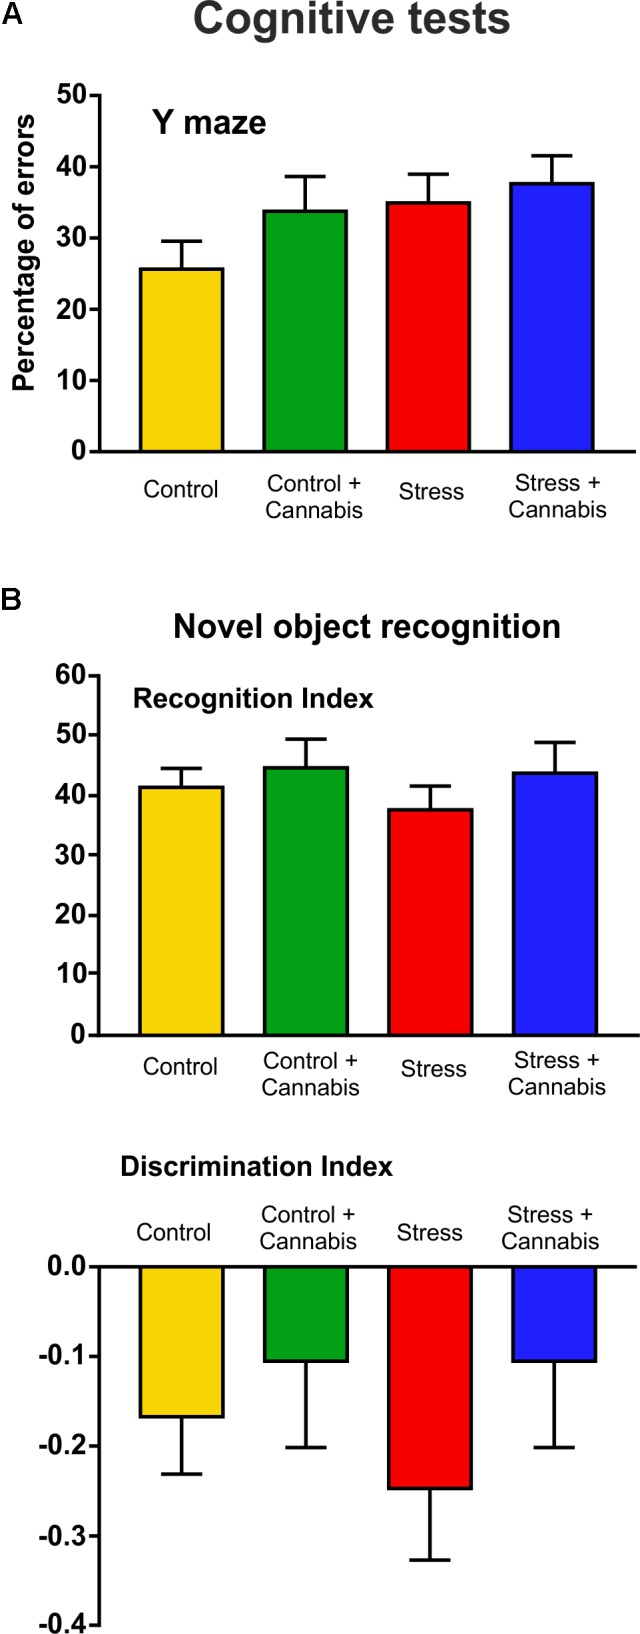
Results of the cognitive tests: Neither stress, nor marijuana exposure affected the cognitive abilities of the animals. Cognitive performances were measured in the Y maze (A) and with the novel object recognition test (B). (A) Stressed and/or cannabis treated mice tended to make more errors in the Y maze test, i.e., they entered to arms which have been recently visited, but statistically there was no difference between the groups. (B) The recognition indexes (time spent with novel object/time spent with both objects × 100) were also similar for all experimental groups. Marijuana treated animals had the tendency to have a lower discrimination index [(time spent with novel object – time spent with familiar object)/time spent with both objects], but statistically this was not significant. Data were analyzed with a two-way ANOVA (stress × cannabis treatment).